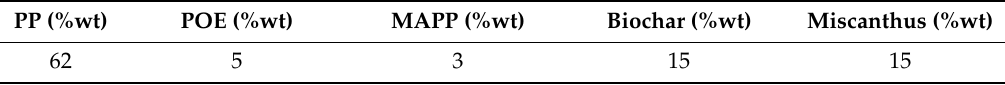
Table 1. Composition of hybrid